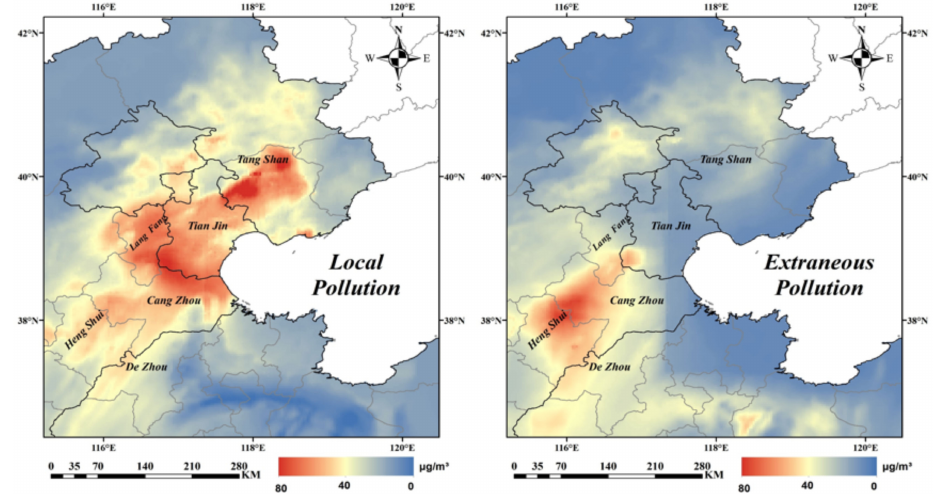
Figure 9. The distribution of the average contribution of local emission and external transmission of fine particulate matter in the time period 7:00–16:00 h, 22 September